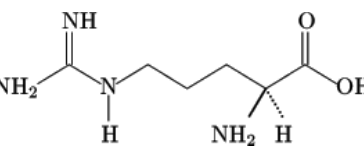
Figure 4. Structure of Arginine.